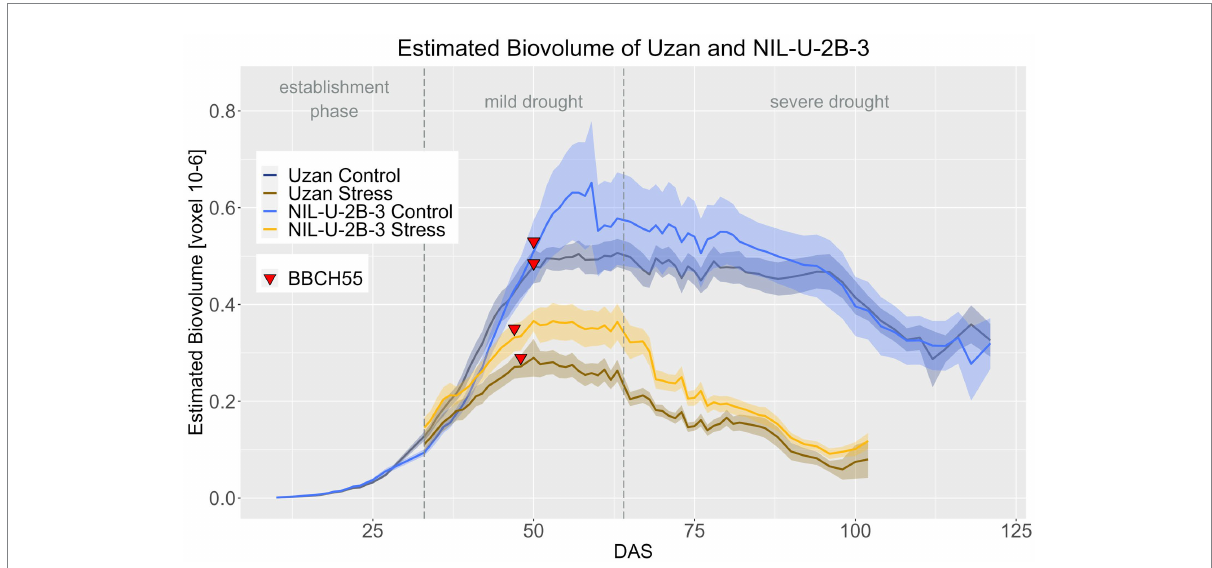
FIGURE 10 Estimated biovolume of Uzan and NIL-U-2B-3 based on the calculated BLUEs values. DAS, days after sowing; BBCH55, heading day. The last DAS for each genotype was chosen for the DAS where the last time 60% of the plants were images (as mature plants were taken off subsequently). The shadows describe the confidence interval; as long as the shadows of the individual lines do not overlap, the significance level of a = 0.05 is not reached and therefore a significant difference exists.